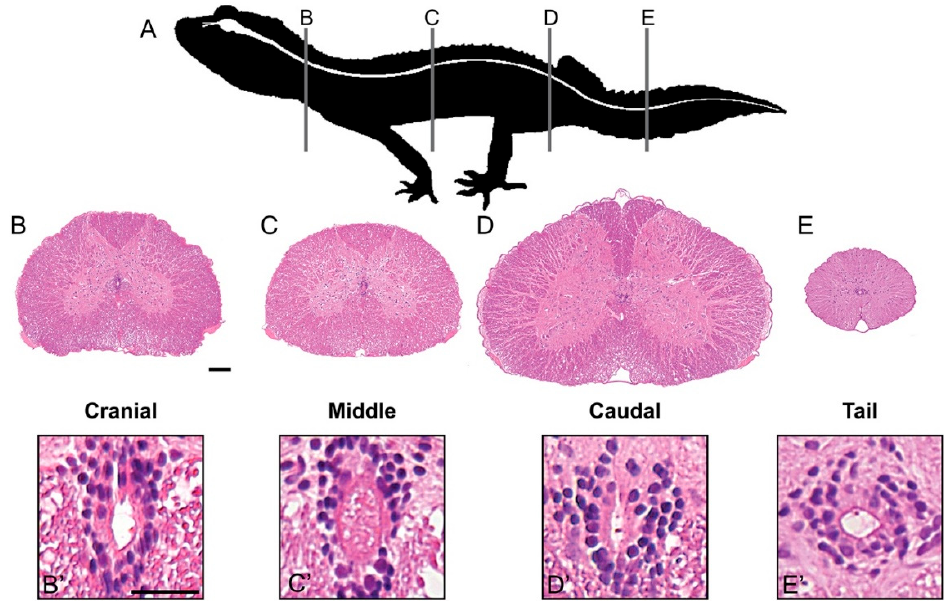
Figure 2. The gecko spinal cord has a consistent histological organization across its length. ( A ) Sche- matic representation of the leopard gecko ( Eublepharis macularius ) in lateral view. The central nerv- ous system is highlighted in white. Vertical lines indicate the location and plane of section of panels ( B – E) . ( B – E ) Serial sections of the spinal cord in transverse plane, stained with hematoxylin and Eosin. Note that though the organization remains consistent along the length of the spinal cord, the proportions of grey to white matter and spinal cord diameter vary slightly with position. ( B’ - E’ ) The central canal is lined by a pseudostratified layer of ependymal cells. The central canal and ependy- mal layer exhibit a more ovoid shape cranially, and progressively round caudally. Note the presence of cilia in the lumen of the central canal. Scale bars: ( B – E ) = 100µm; ( B’ – E’ ) = 25 µm.